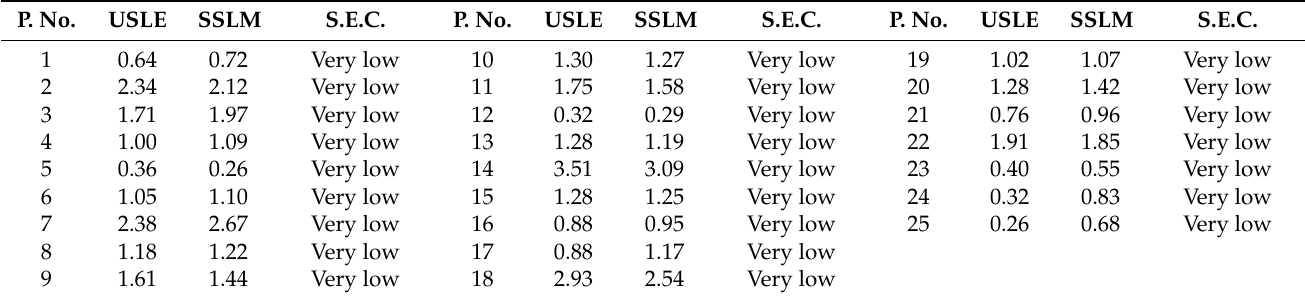
Table 12. Soil erosion rates and classes according to the USLE model and the proposed model (SSLM). P.